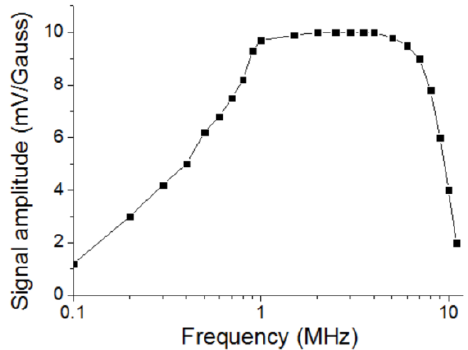
Figure 3. Signal amplitude of the magnetic sensor changing with the frequency of the AC bias current.